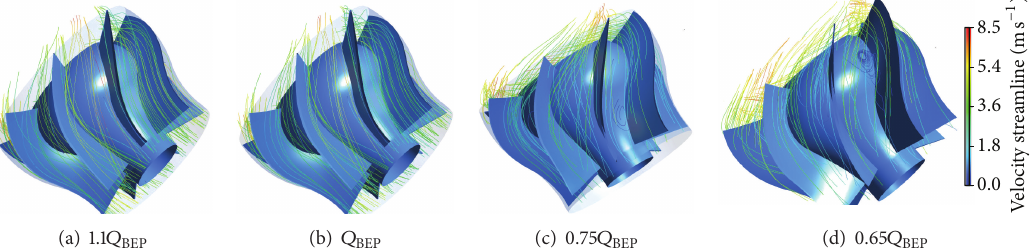
Figure 13: Three-dimensional streamlines in the vane